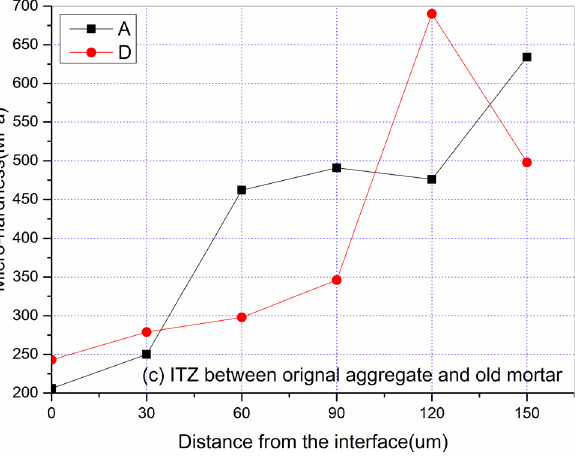
Figure 9: Micro-hardness in different ITZs of specimen A and specimen D a) ITZ between old mortar and new mortar; b) ITZ between